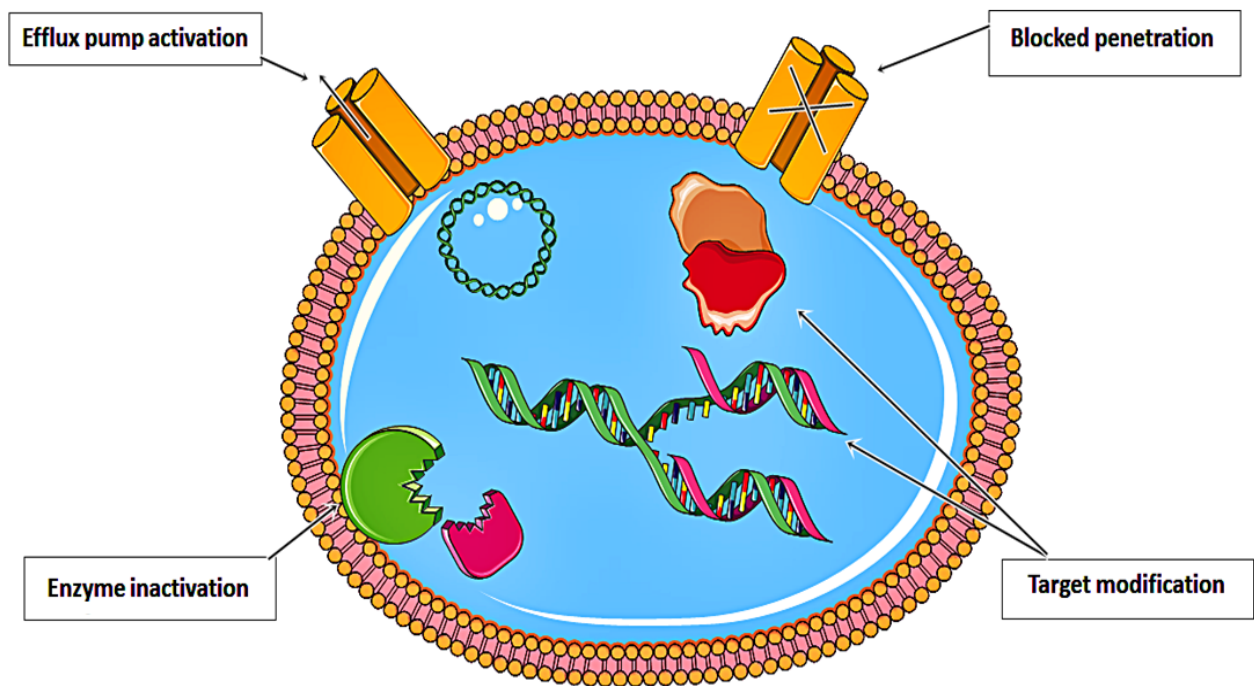
Figure 1. Resistance strategies developed by anticancer drugs that limit their therapeutic efficiency.